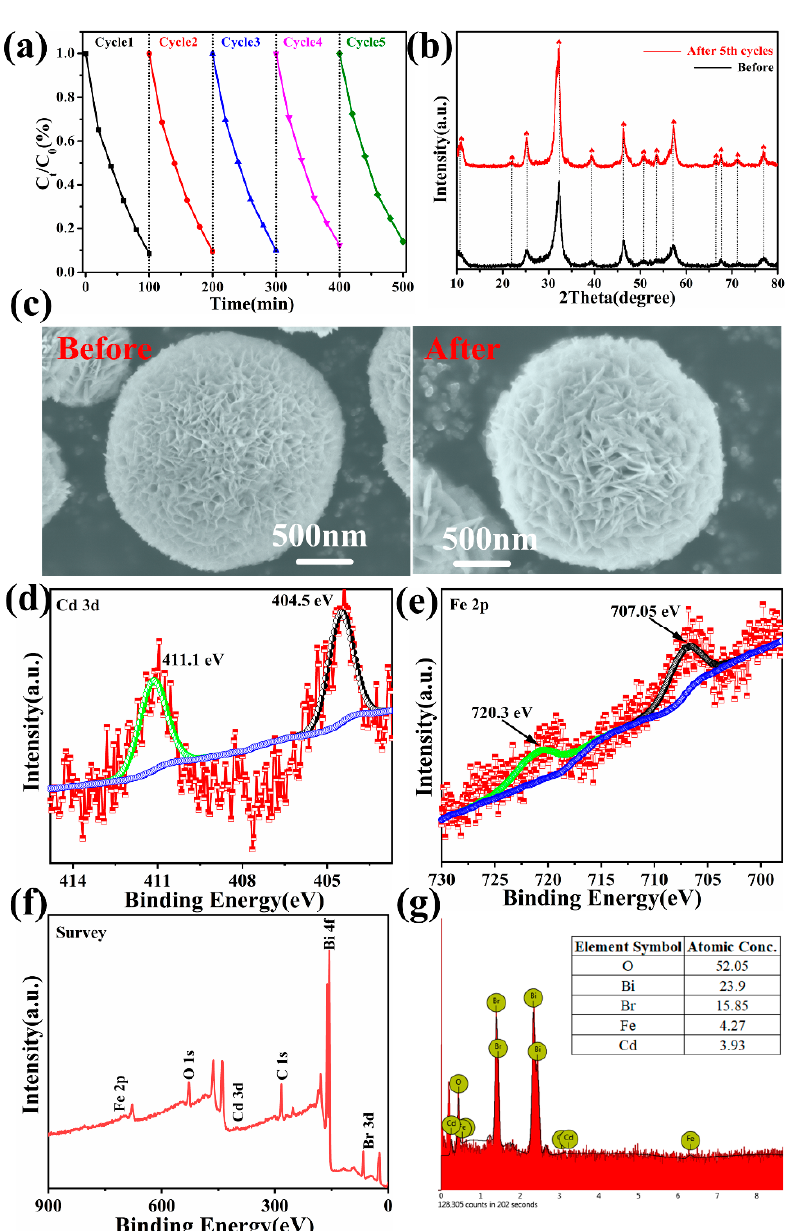
Figure 9. Recycle experiments of Bi 1 − x − y Cd x Fe y OBr photocatalysts for photodegraded RhB ( a ); XRD patterns ( b ); SEM images ( c ); high-resolution XPS spectra: Cd 3d spectrum ( d ), Fe 2p spectrum ( e ) and survey spectrum ( f ); EDS spectrum ( g ) of after the photocatalytic cyclic reactions.